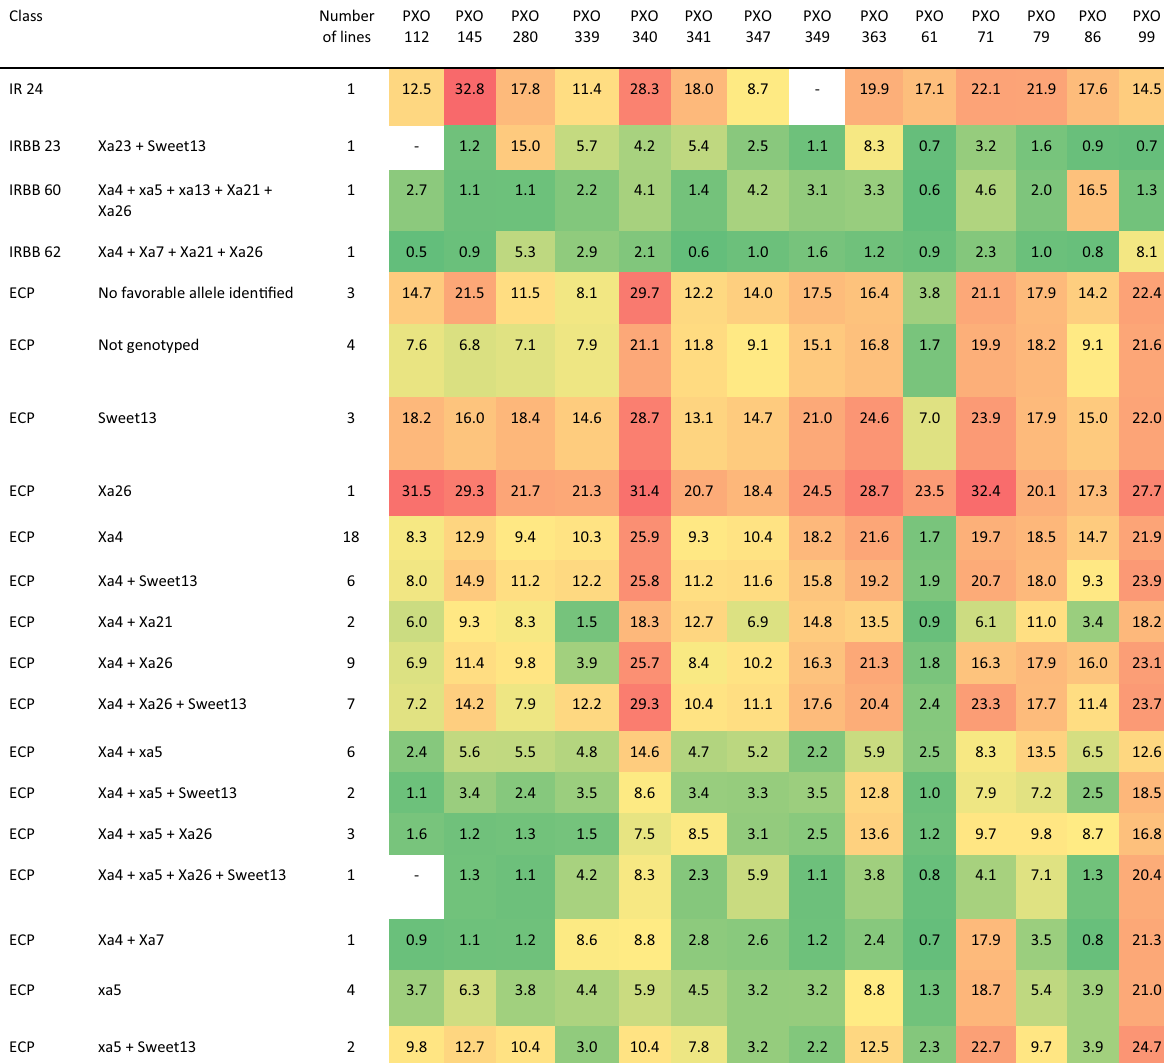
Table 3 Response of the elite core panel to bacterial leaf blight under controlled environment Class Number of